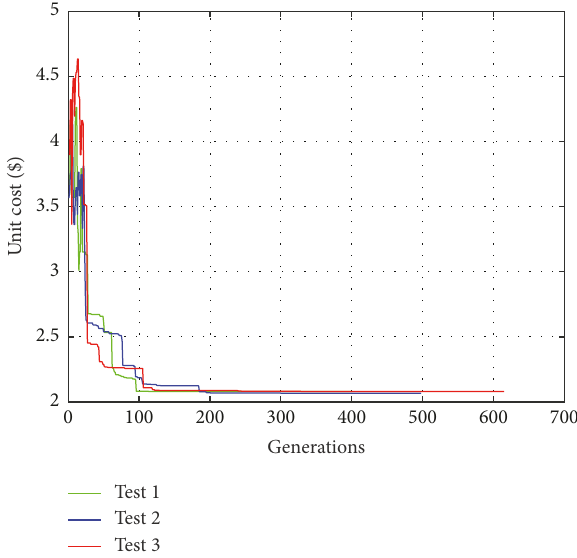
Figure 3: Trend of unit cost by HSAGA.